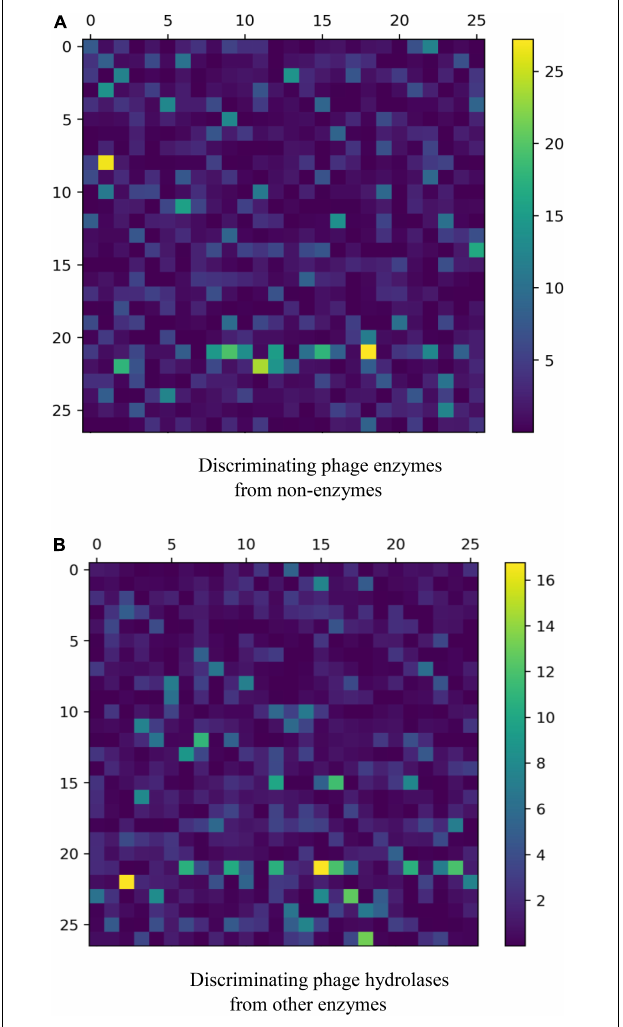
FIGURE 1 | A plot showing the F -values for (A) discriminating phage enzymes from nonenzymes and (B) discriminating phage hydrolases from other enzymes.